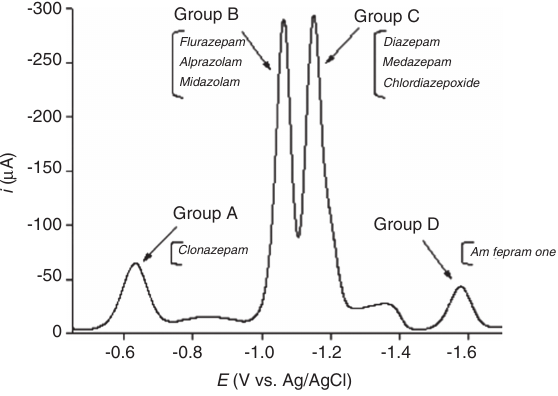
Figure 1 Voltammetric signals at HMDE of a 1,4-benzodiazepine mixture and amfepramone in Ringer buffer at pH 10.0. clonaz- epam = 6 × 10 –5 m; amfepramone = 3 × 10 –5 m; other benzodiazepines: 1 × 10 –5 m. Negative-going potential scan; pulse mplitude 50 mV, pulse duration 40 ms, scan rate of 50 mV s –1 . From De Carvalho et al. 2010c, with